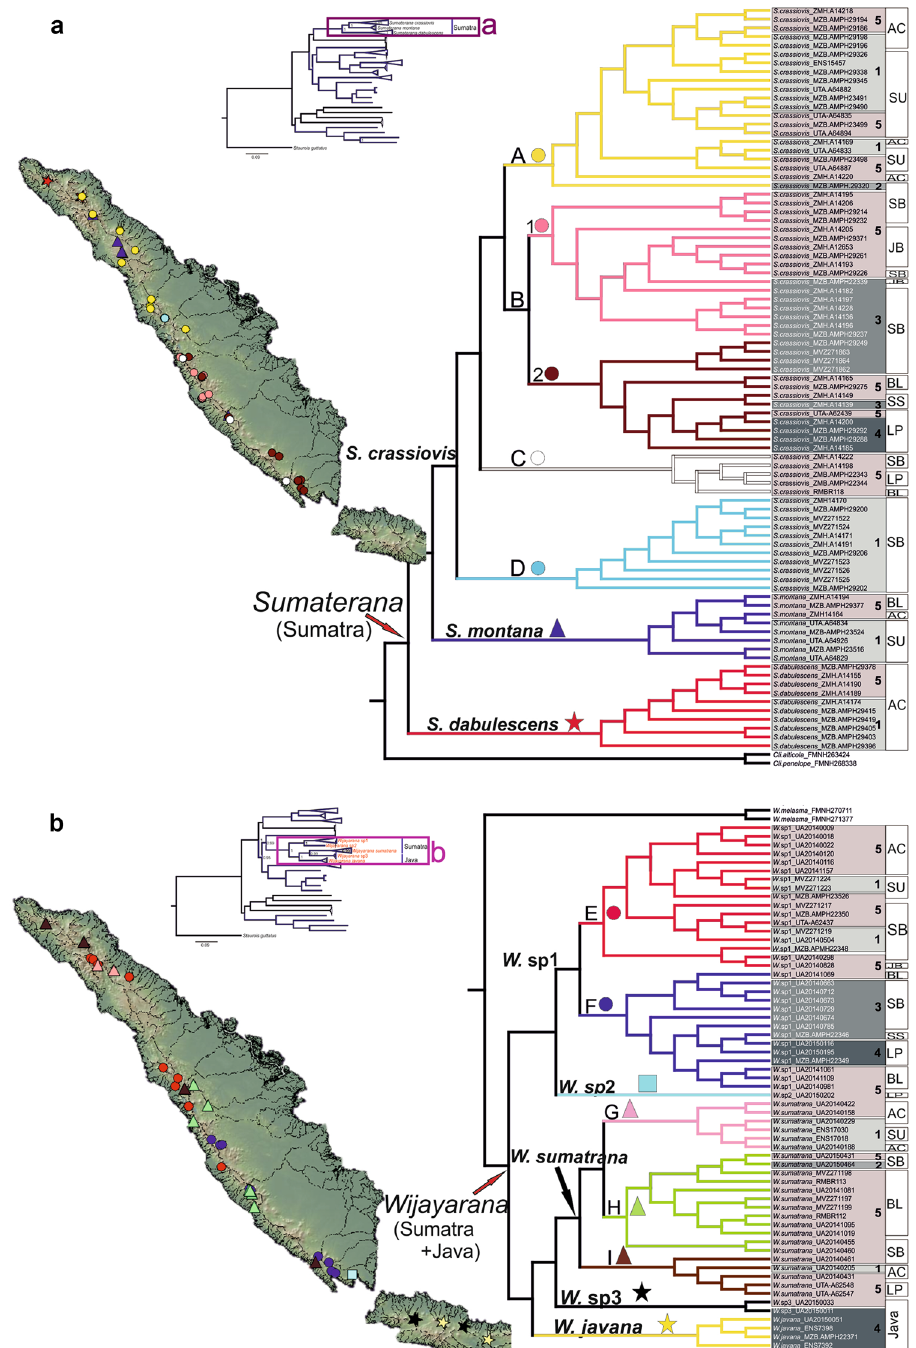
Figure 2. Distribution of Sumaterana ( a ) and Wijayarana ( b ) mapped over watersheds occurring on the island of Sumatra created using GeoMapApp (www. geoma papp. org). Colors on each branch represent the sampling locality of their respective taxa: Sumaterana crassiovis (clade A–D: yellow, pink, brown, white, light blue circles), S. montana (dark blue triangles), S. dabulescens (red star), W. sp1 (clade E–F, red and dark-blue circles), W. sp2 (light blue square), W. sumatrana (cade G–I: pink, green, brown triangles), W. sp3 (black star), W. javana (yellow star). Watersheds are color-coded and numbered with 1–5: 1 (Malacca Strait River System), 2 (Siam River System), 3 (North Sunda River System), 4 (East Sunda River System), 5 (watersheds that run into the Indian Ocean). Provinces on Sumatra indicated by AC (Aceh), SU (Sumatera Utara), SB (Sumatera Barat), JB (Jambi), BL (Bengkulu), SS (Sumatera Selatan), LP